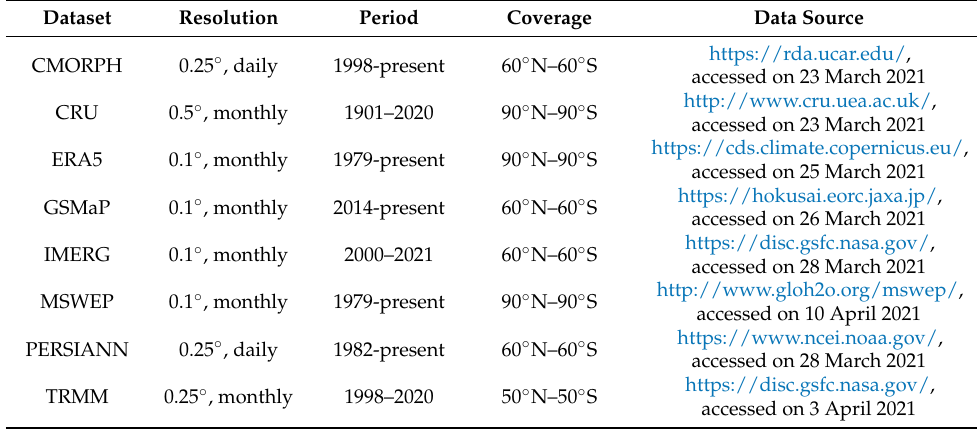
Table 1. Summary of high-resolution gridded precipitation products used in this